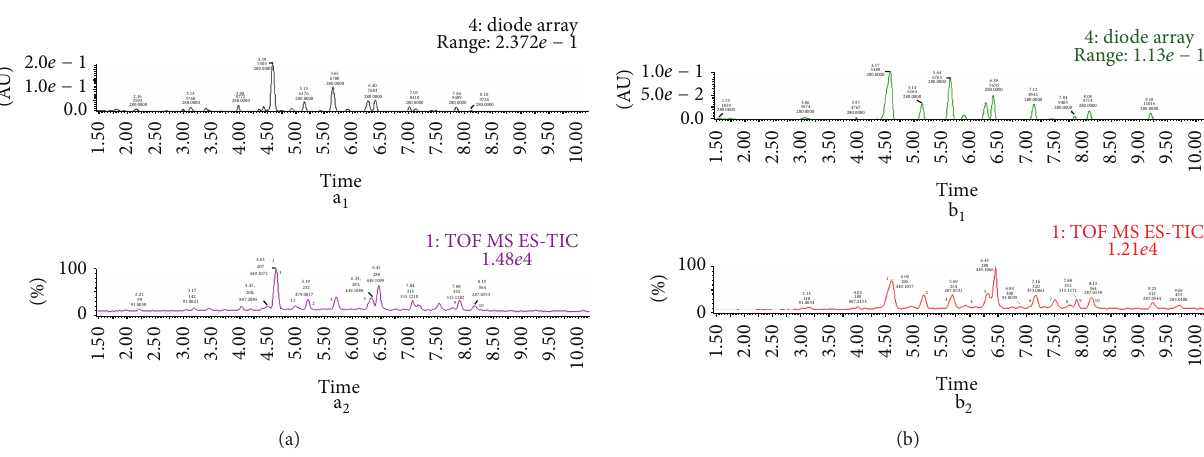
Figure 1: LC-MS chromatographic profile of CTF extracts. (a) Ms spectra at 280 nm (a 1 ) and absorbance spectra (a 2 ) of the WEC. (b) Ms spectra at 280 nm (b 1 ) and absorbance spectra (b 2 ) of the EEC. 1: 3 󸀠 ,5,5 󸀠 ,7-Tetrahydroxyflavanone-O-hexoside; 2: Quercetagitin-7-O- glucoside; 3: Okanin; 4: 3,4 󸀠 ,5,6,7-Pentahydroxyflavanone; 5: Luteolin-7-O-glucoside; 6: Chlorogenic Acid; 7: Luteolin; 8: Coreopsin; 9: